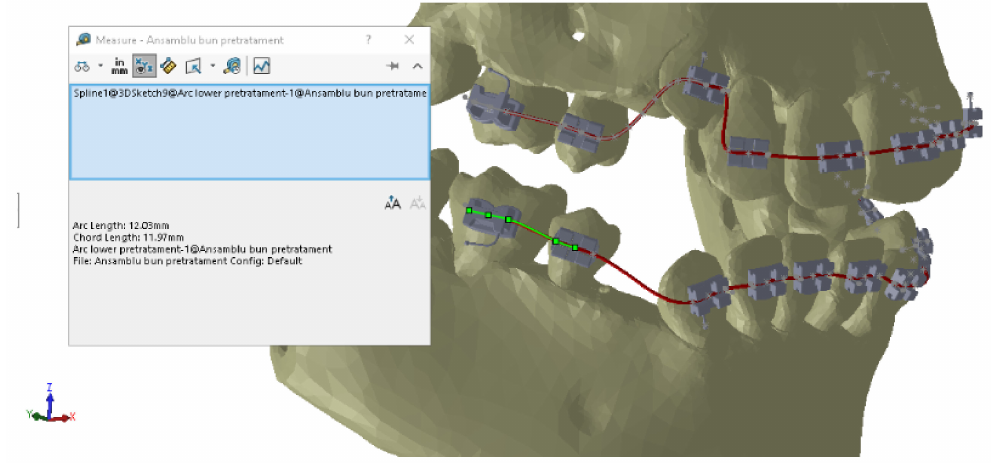
Figure 25. Measurements of the y coordinates for 4.5.